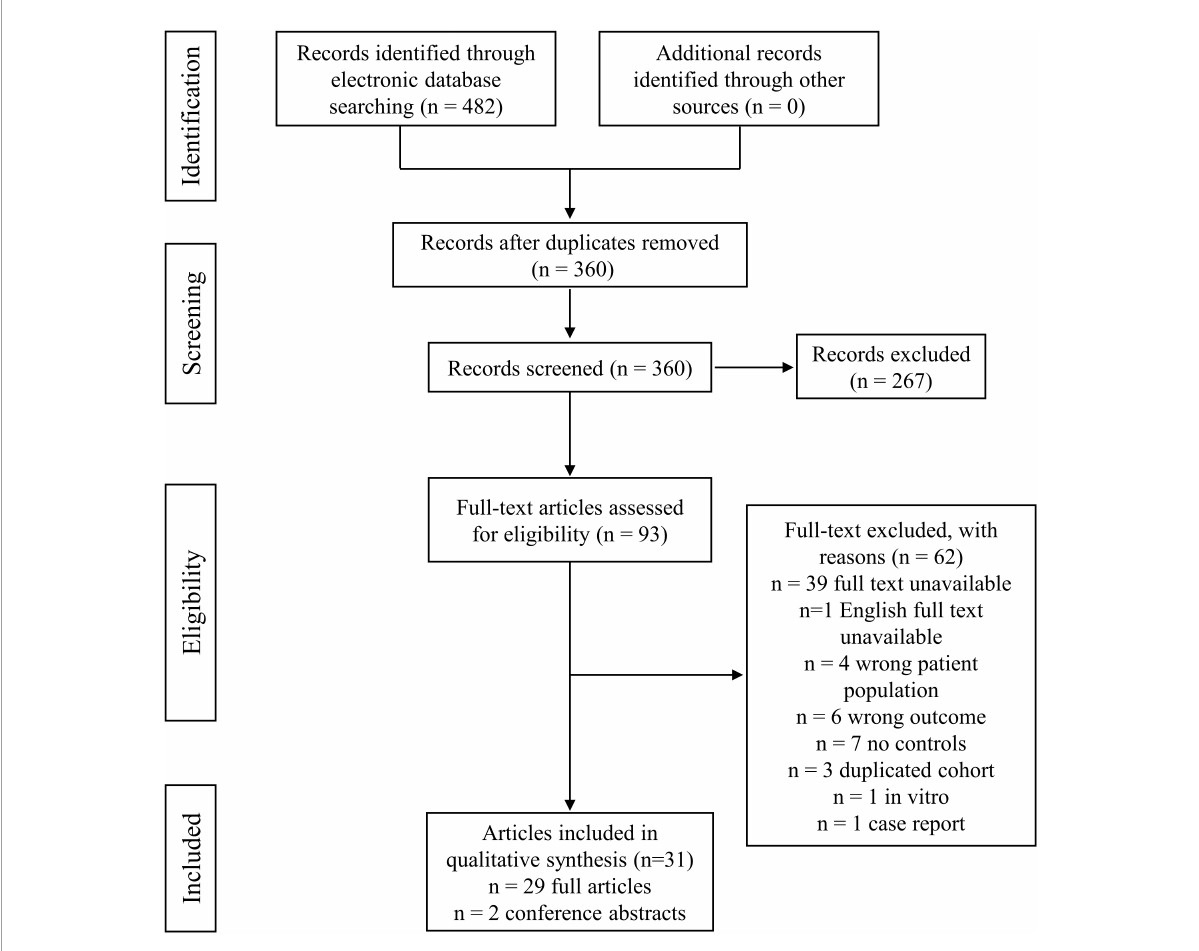
FIGURE1 Flow diagram of study selection and data collection